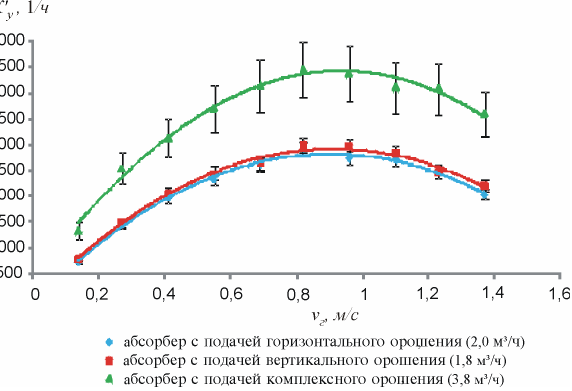
Рис. 5. Зависимость условного объемного коэффици- ента абсорбции от линейной скорости газов при Fig. 5. Dependence of notional volume ratio of absorption on linear gas speed under various types of sprinkling supply